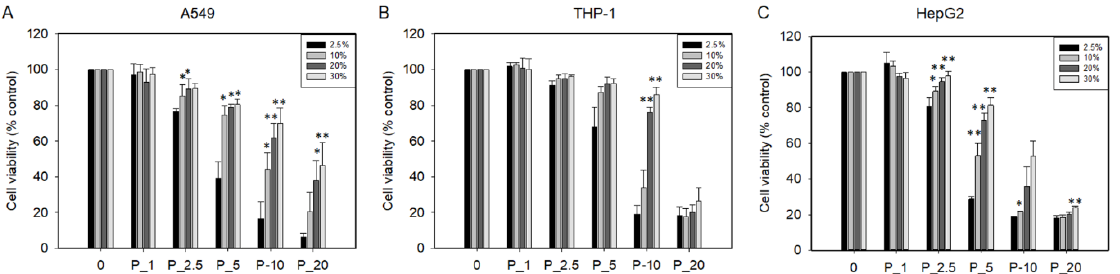
the epithelial cell. Scale bar: 20 µ m.